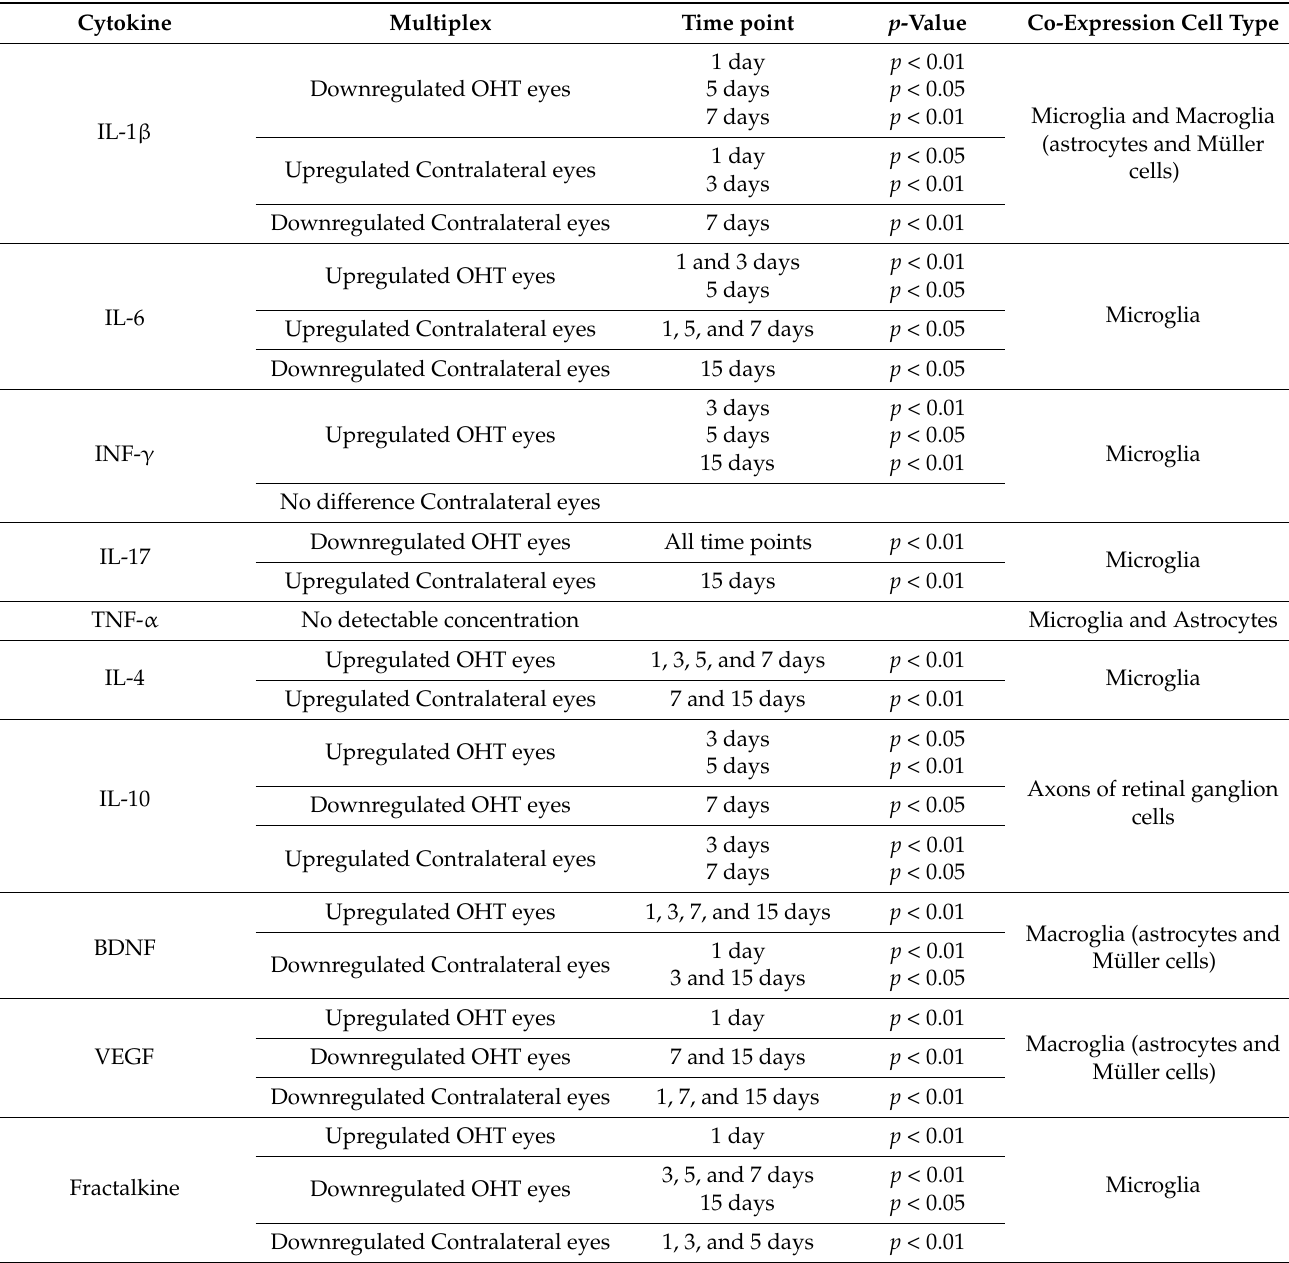
Table 1. Multiplexed immunoassay and immunohistochemical